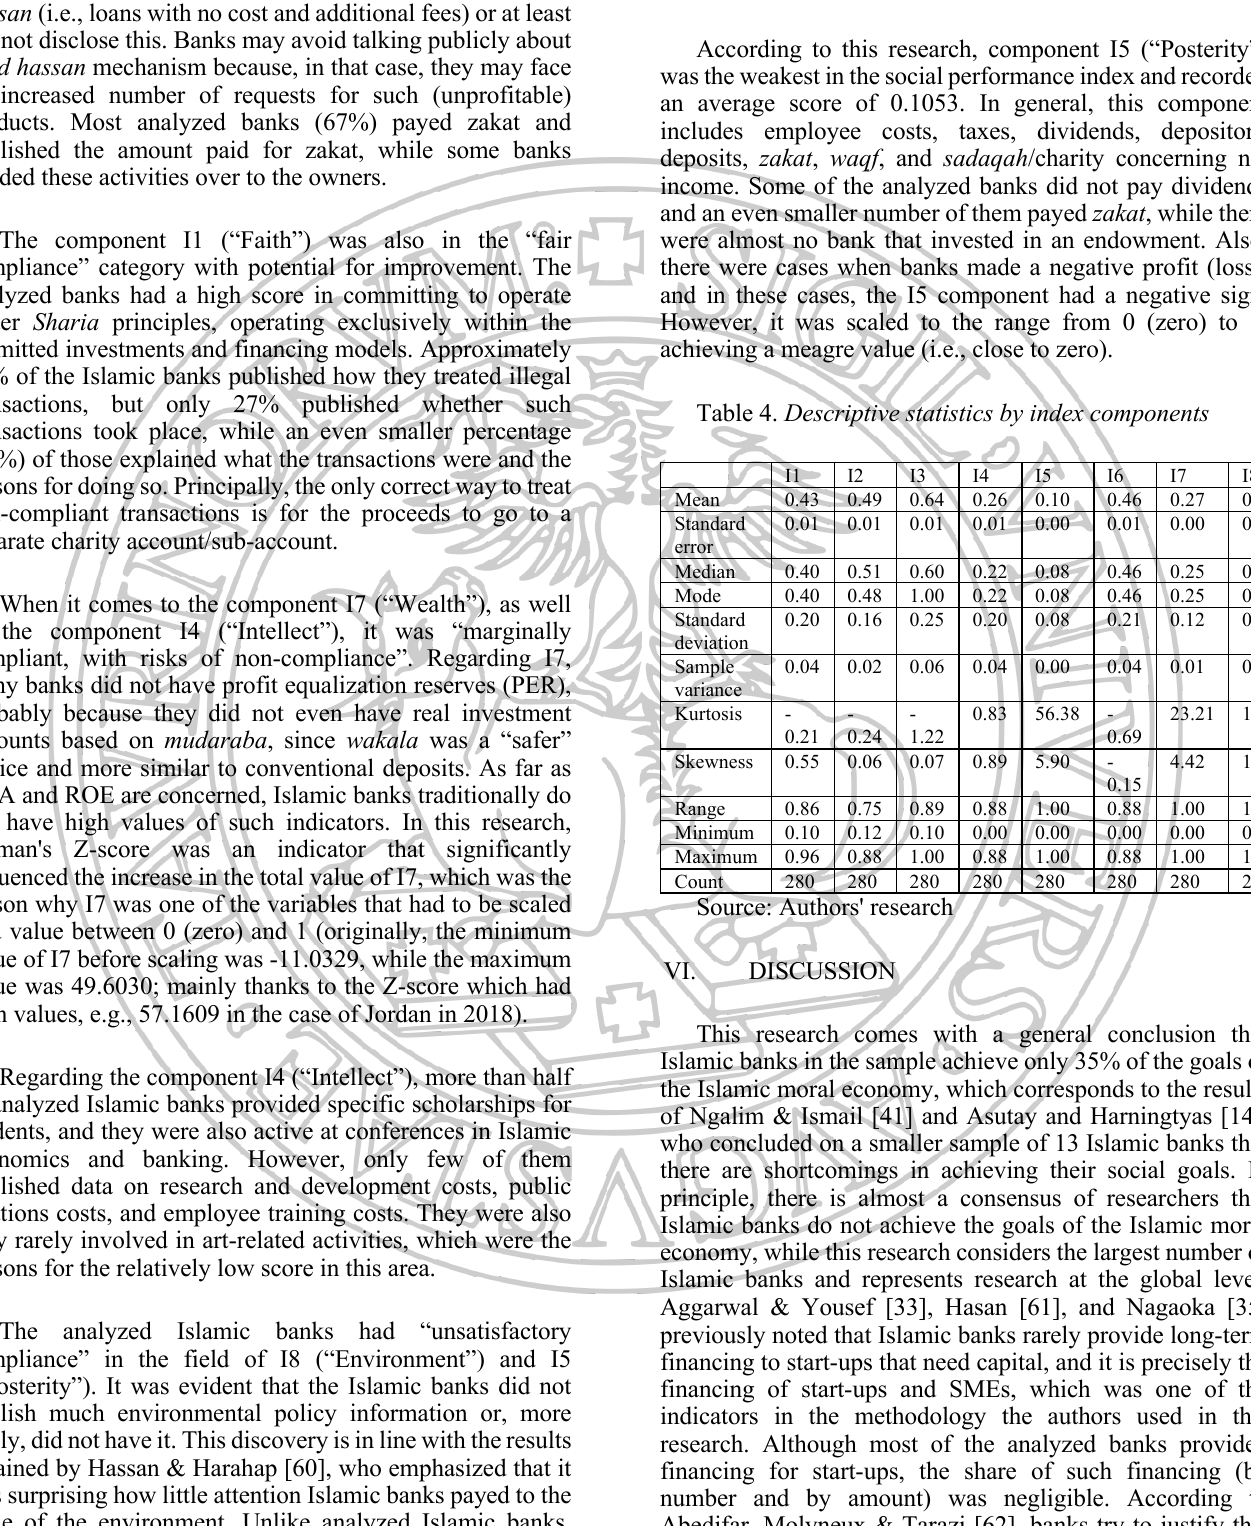
Table 4. Descriptive statistics by index